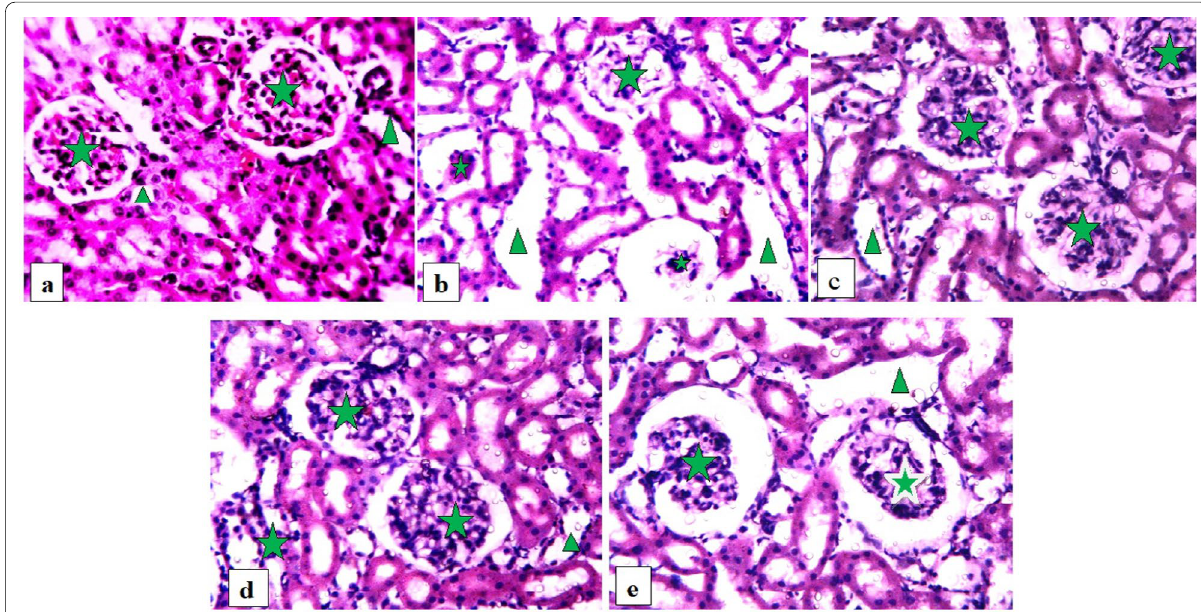
Fig. 4 Photomicrographs of sections of kidney of a control ( a ) showing histological structure of the kidney with normal glomerulus (star) and renal tubules (arrow head), Lead acetate treated micrograph ( b ) showing marked degenerated glomerulus and spontaneous lipid vacuolation of the glomerulus (star), Extract 250/500 mg/kg lead acetate 30 mg/kg ( c , d ) respectively showing normal glomerulus (star) and some mild tubular + damage (arrow head), Succimer 5